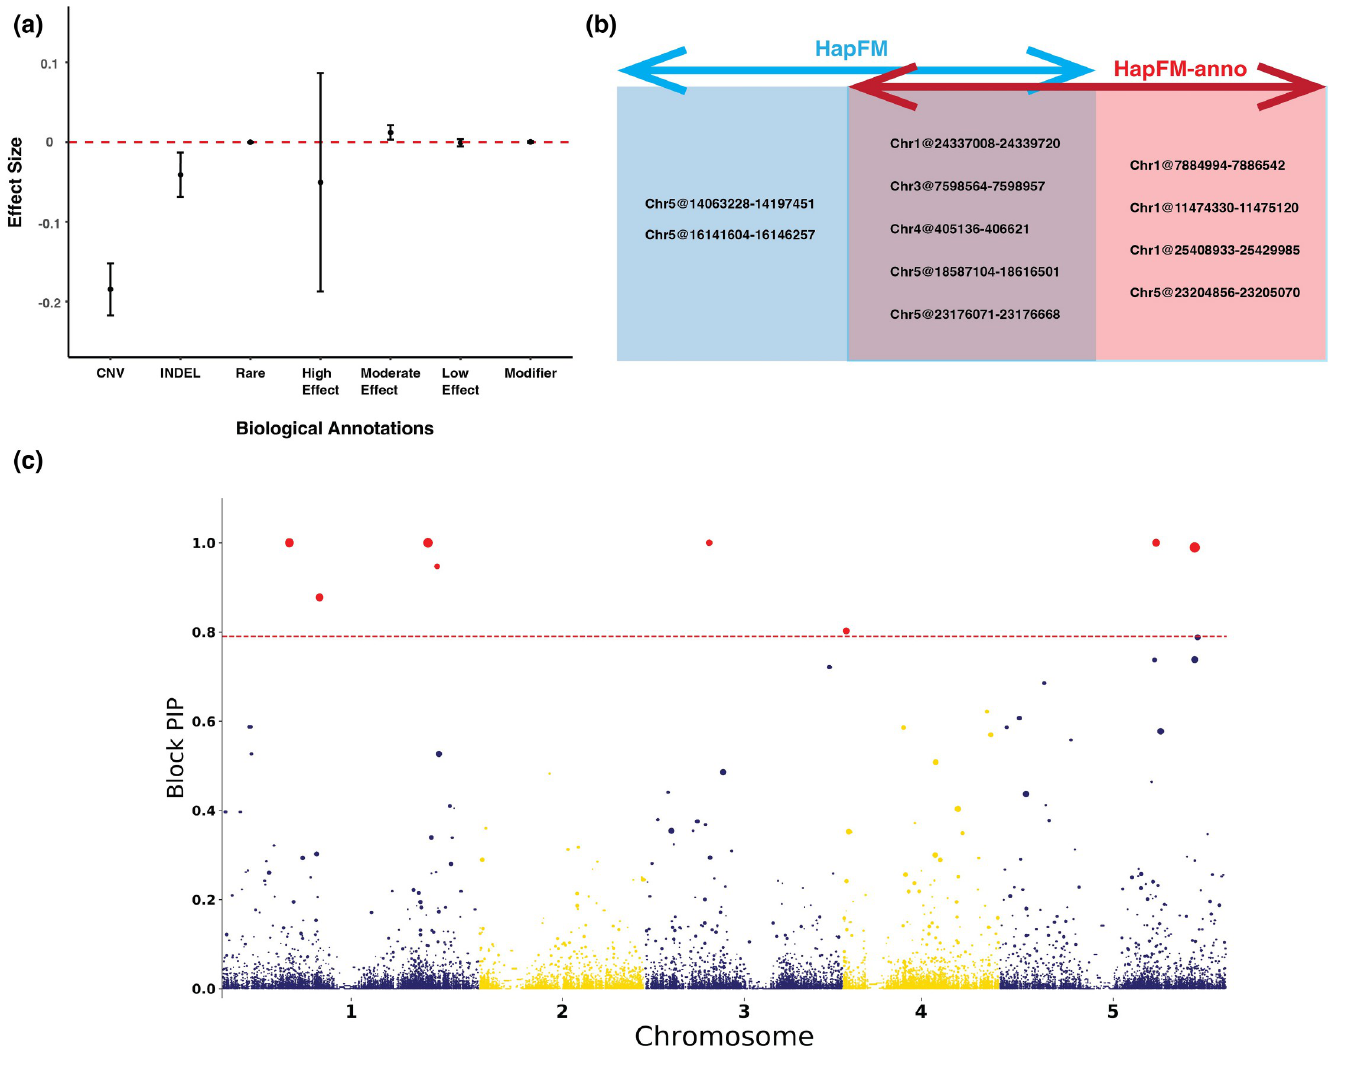
Fig 6. Arabidopsis flowering time GWAS results using biological-informed priors (HapFM-anno). (a) The estimated effect sizes of different biological annotations for the Arabidopsis flowering time dataset. (b) The comparison of significant loci identified with and without incorporating biological annotations. (c) Manhattan plot of HapFM-anno on Arabidopsis flowering time (FT10) dataset. The red dash line indicates the FDR 0.05 threshold. The size of the dot indicates the estimated effect size of the block.